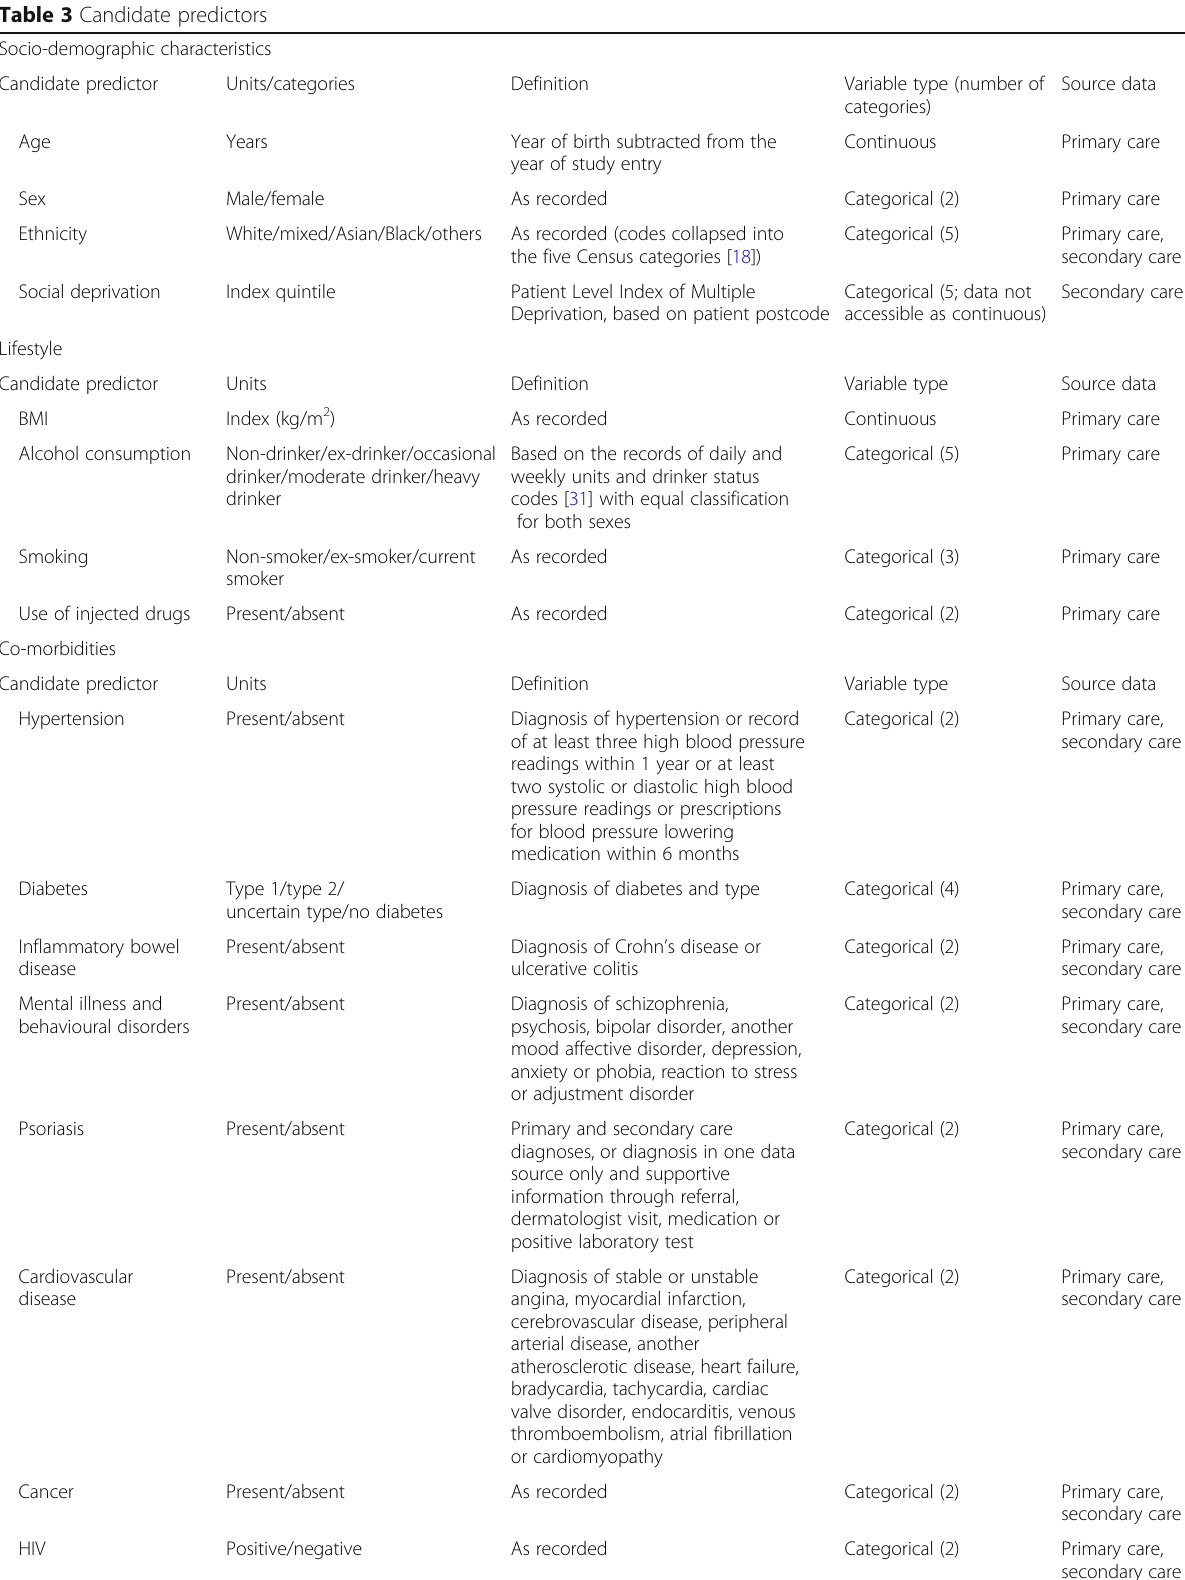
Table 3 Candidate predictors Socio-demographic